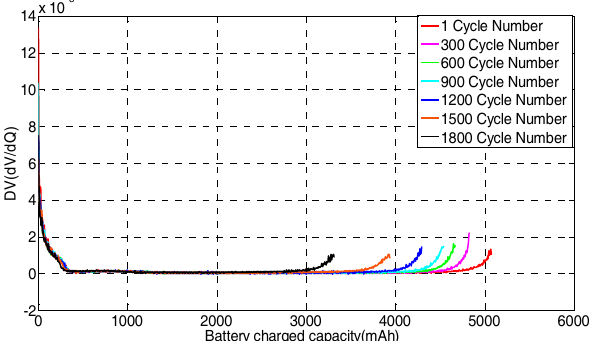
Figure 5. The differential voltage under different cycle numbers.